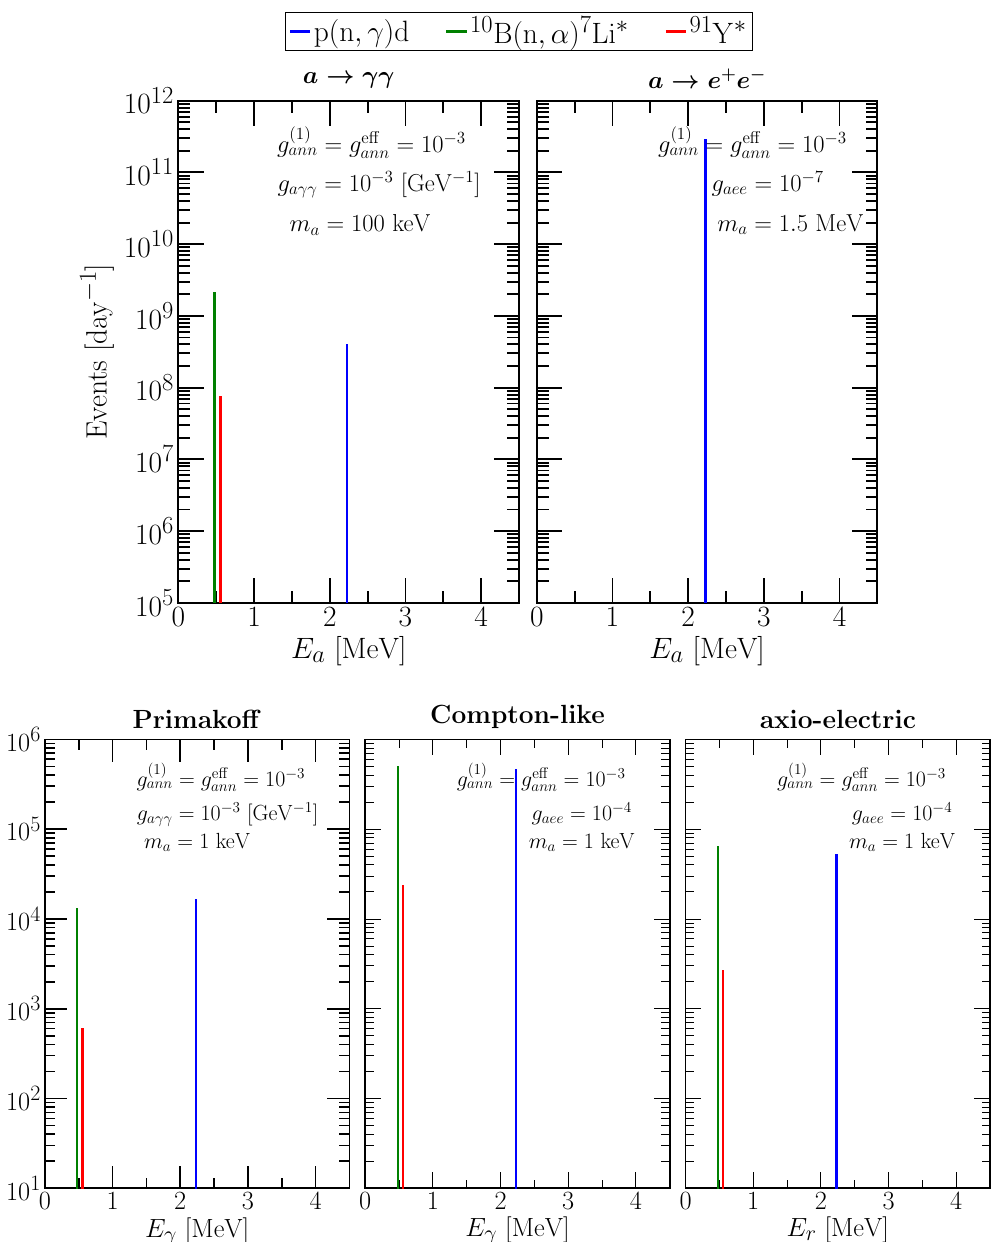
Figure 9 . Event yields for ALP production through magnetic transitions and detection through: decays a → γγ and a → e + e − (left and right upper graphs), inverse-Primakoff scattering a + N → γ + N (left lower graph), Compton-like scattering a + e → γ + e (middle lower graph) and axio- electric absorption a + e + Z → γ + e + Z (right lower graph). The event yield has been calculated for a 4 GW reactor power plant assuming L = 10 m. Here, g eff